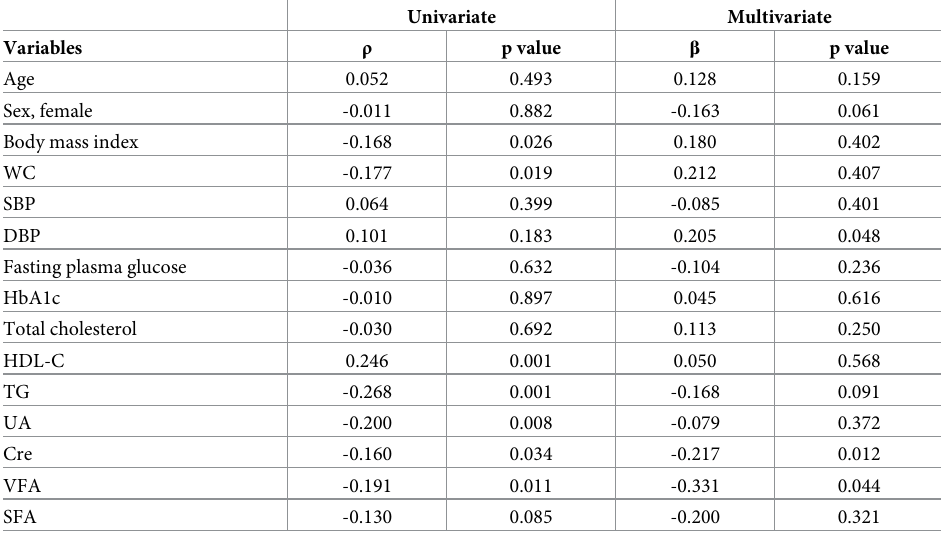
WC; waist circumference; SBP, systolic blood pressure; DBP, diastolic blood pressure; HbA1c, hemoglobin A1c; HDL-C, high-density lipoprotein cholesterol; TG, triglycerides; UA, uric acid; Cre, creatinine; VFA, visceral fat area; SFA, subcutaneous fat